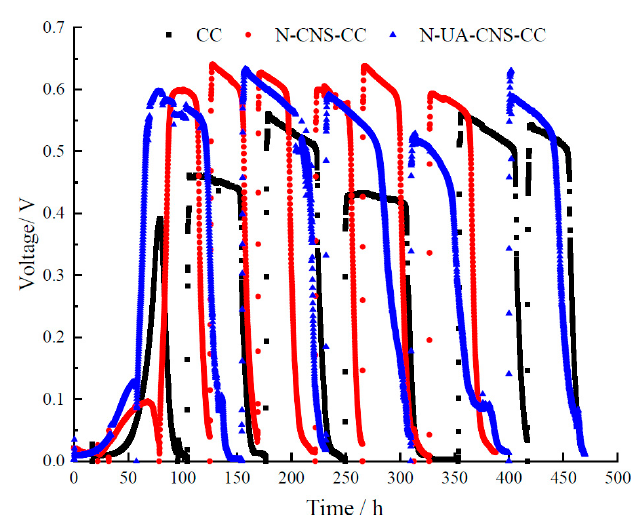
Figure 5. Voltage output of microbial fuel cells (MFCs) with CC, the self-doped-nitrogen porous carbon nanosheets(N-CNS)-CC and the unactivated self-doped-nitrogen porous carbon nanosheets(N-UA-CNS)-CC as anode.